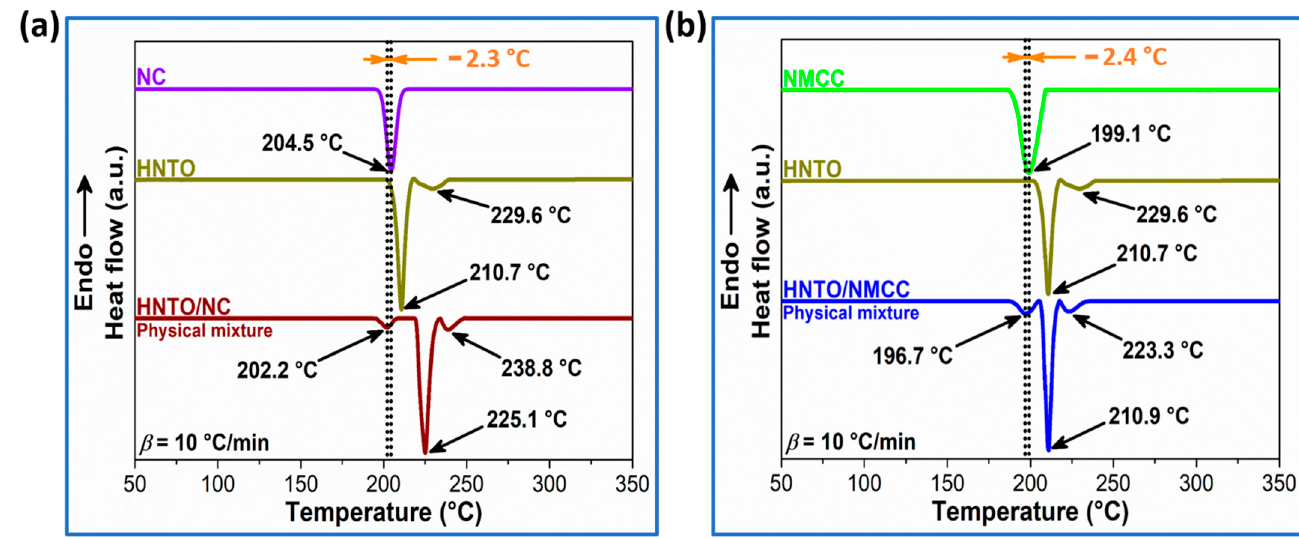
Figure 1. DSC thermograms at a heating rate of 10 °C/min of ( a ) HNTO/NC physical mixture and its single components; ( b ) HNTO/NMCC physical mixture and its single components. its single components; ( b ) HNTO/NMCC physical mixture and its single